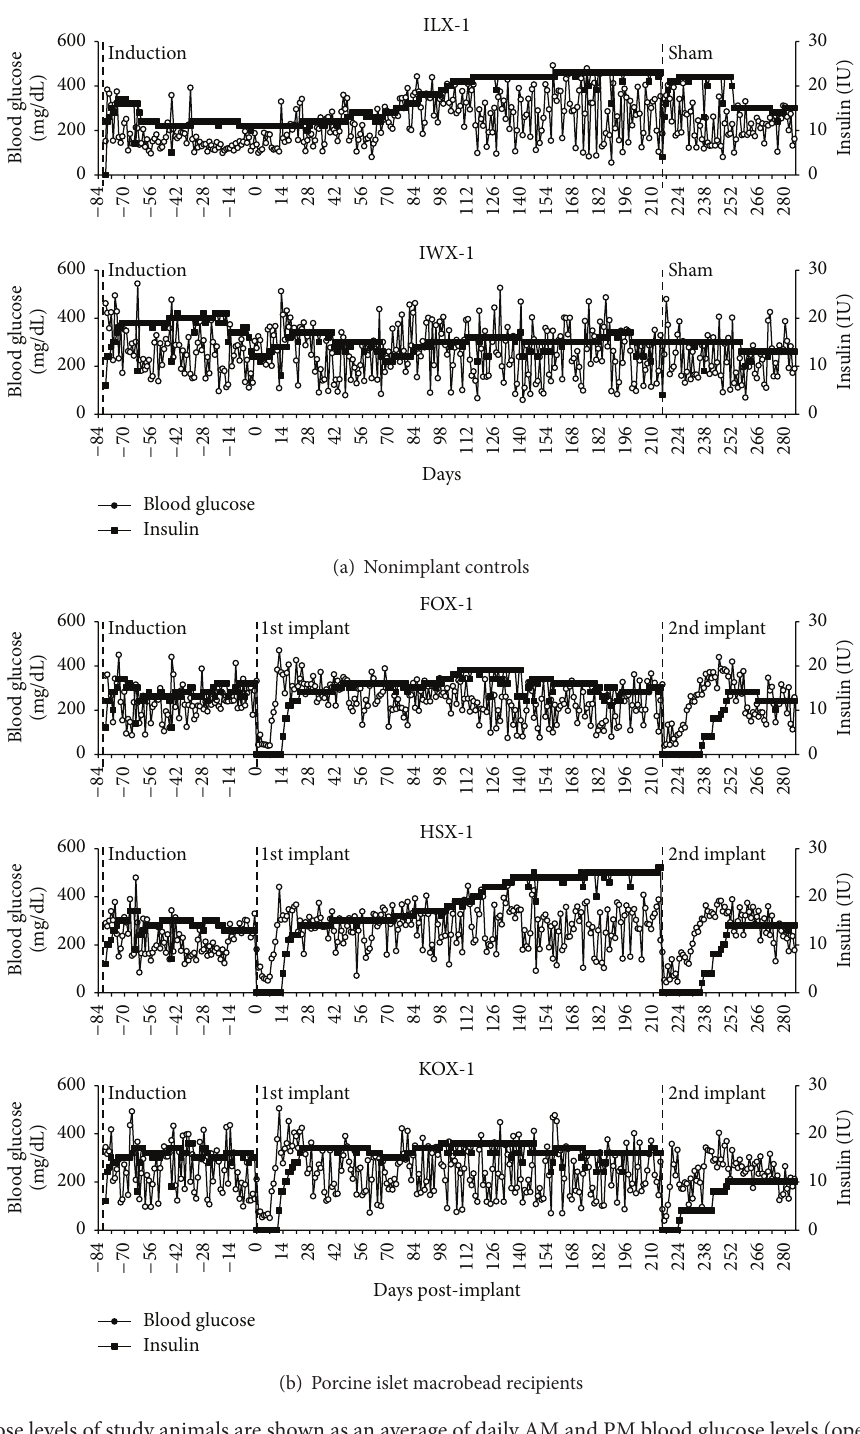
Figure 1: Blood glucose levels of study animals are shown as an average of daily AM and PM blood glucose levels (open circles). Exogenous insulin totals are graphed as a sum of daily AM and PM insulin units received (closed squares). Control animals (did not receive porcine islet macrobeads) are shown in (a) ILX-1 and IWX-1. Animals that received porcine islet macrobeads are shown in (b) FOX-1, HSX-1, and